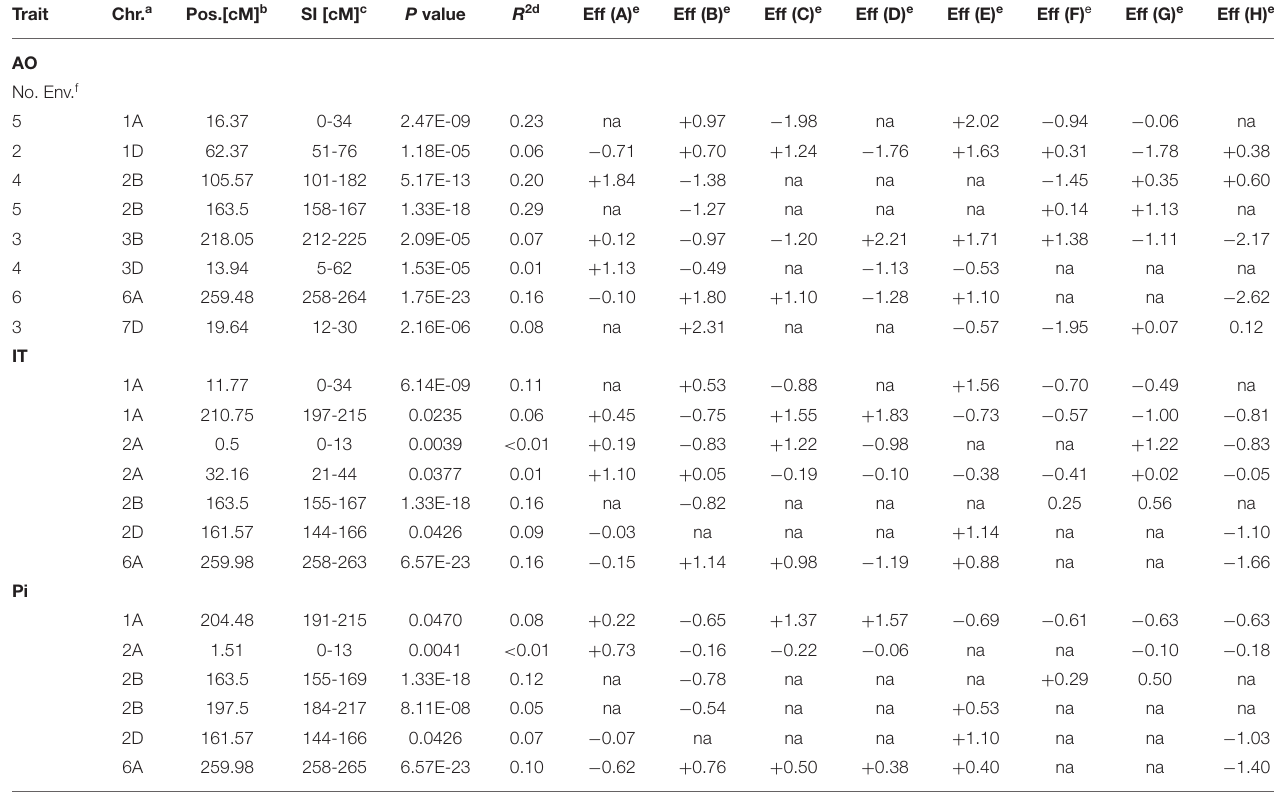
a Chromosomal position of QTL. b Position of peak marker based on the study by Stadlmeier et al. (2018). c Support interval. d Proportion of phenotypic variance explained by a single QTL. e Additive effects ( ± ) of the founders Event (A), Bayp4535 (B), Ambition (C), Firl3565 (D), Format (E), Potenzial (F), Bussard (G), and Julius (H) relative to the population mean. Shown values are back-transformed to the original trait scale. f Number of single environments in which a QTL was detected. Founder effects were reported as not available (na) if none of the RILs reached the probability